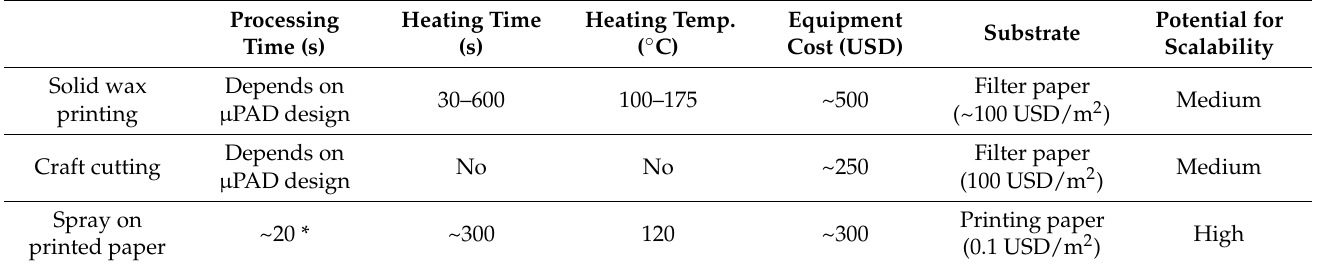
Table 1. Comparison between commonly used techniques and proposed